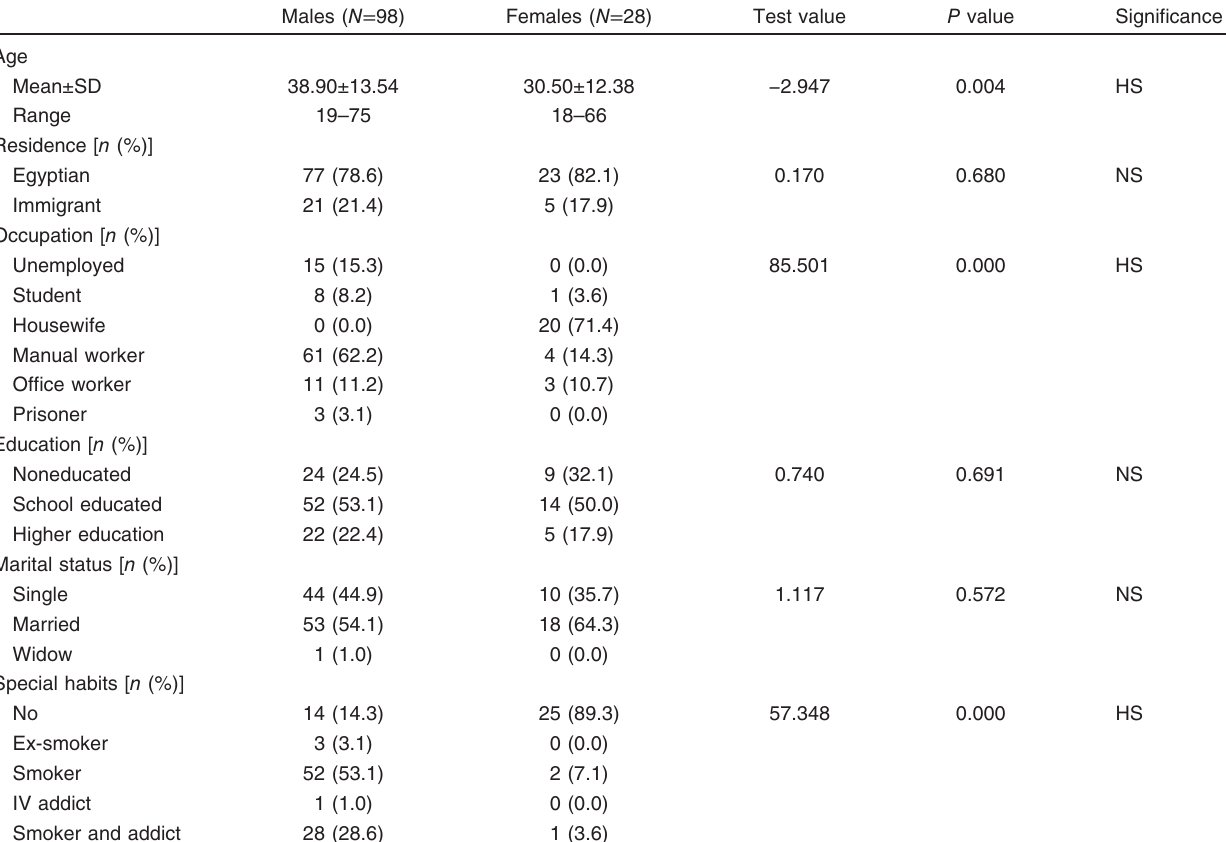
Table 1 Comparison of the sociodemographic data between females and males Males ( N = 98)